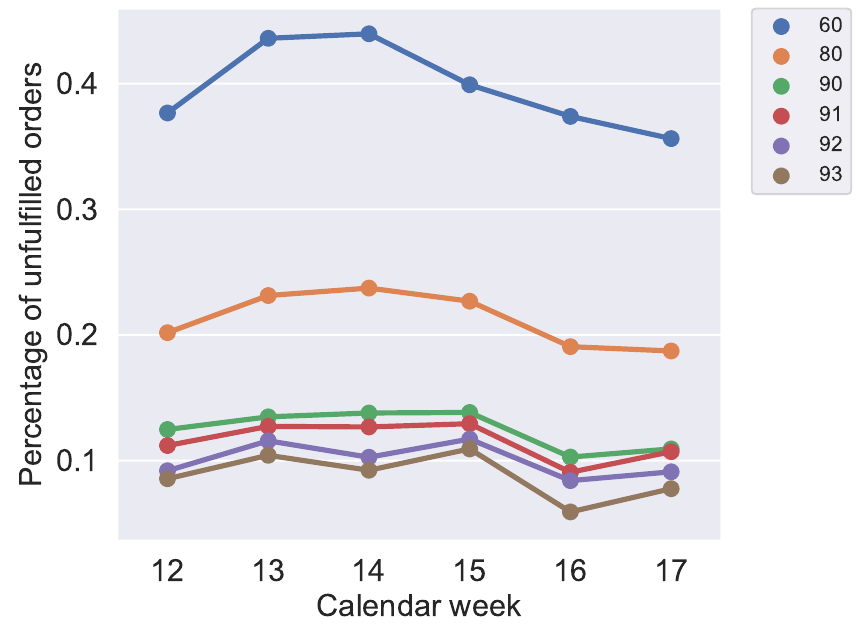
Figure 16. Average percentage of unfulfilled orders per quantile over all simulation runs.